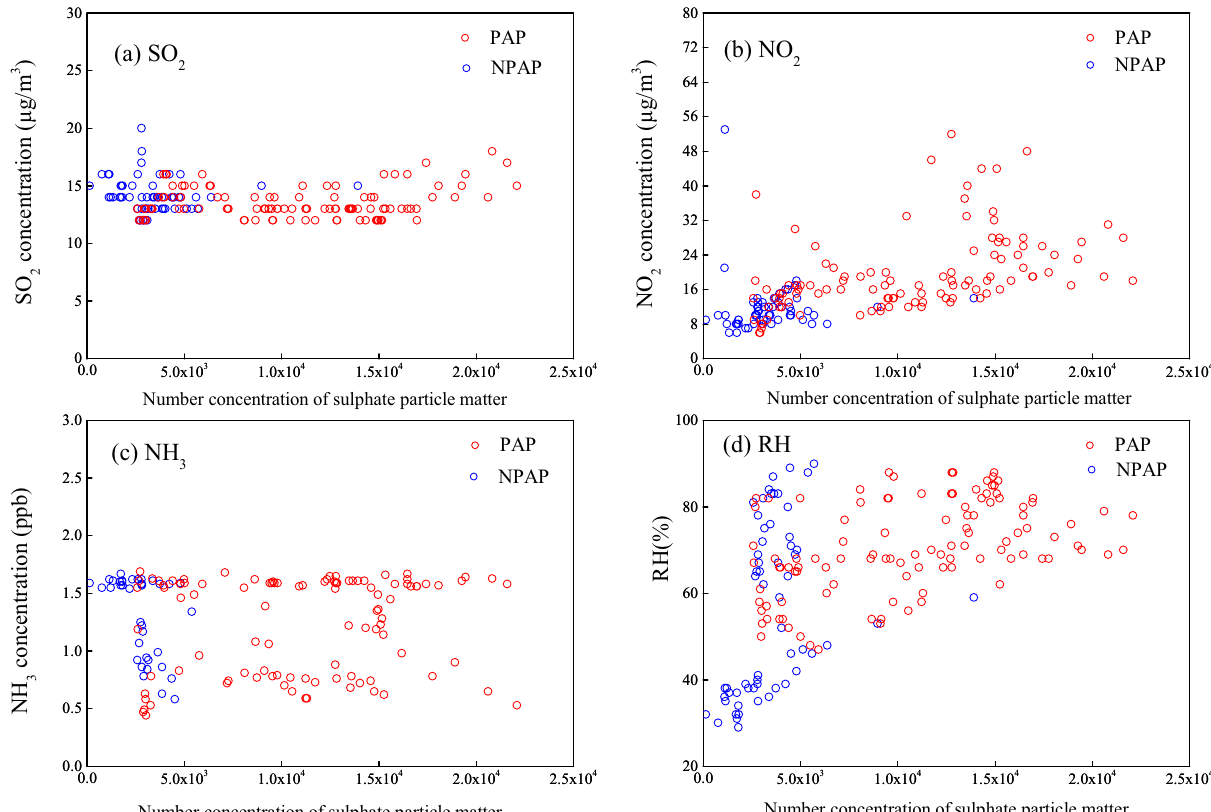
Figure 4. Number concentration of sulphate particulates versus ( a ) concentration of SO 2 ; ( b ) concentration of NO 2 ; ( c ) concentration of NH 3 and ( d ) RH during the pollution accumulation period (PAP) and non-pollution accumulation period (NPAP, i.e. pre-pollution and pollution dissipation period) from February 18 to 24,